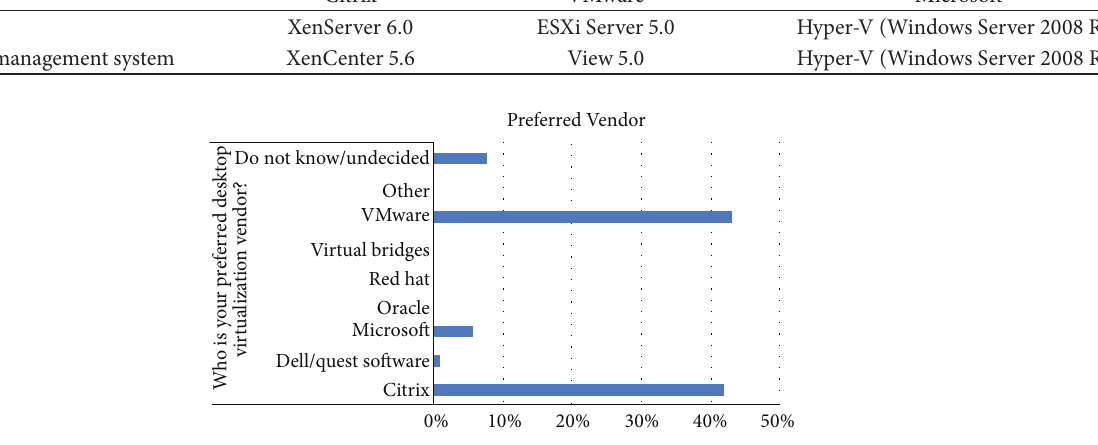
Figure 1: Desktop virtualization trends at the Gartner Data Center